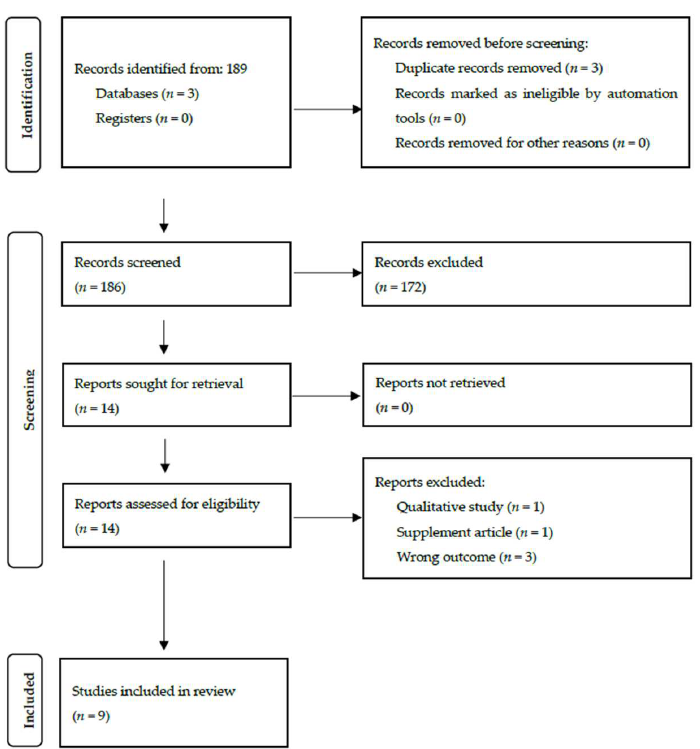
Figure 1. Study selection process shown by PRISMA 2020 flow diagram for new systematic reviews including searches of databases, registers, and other sources.